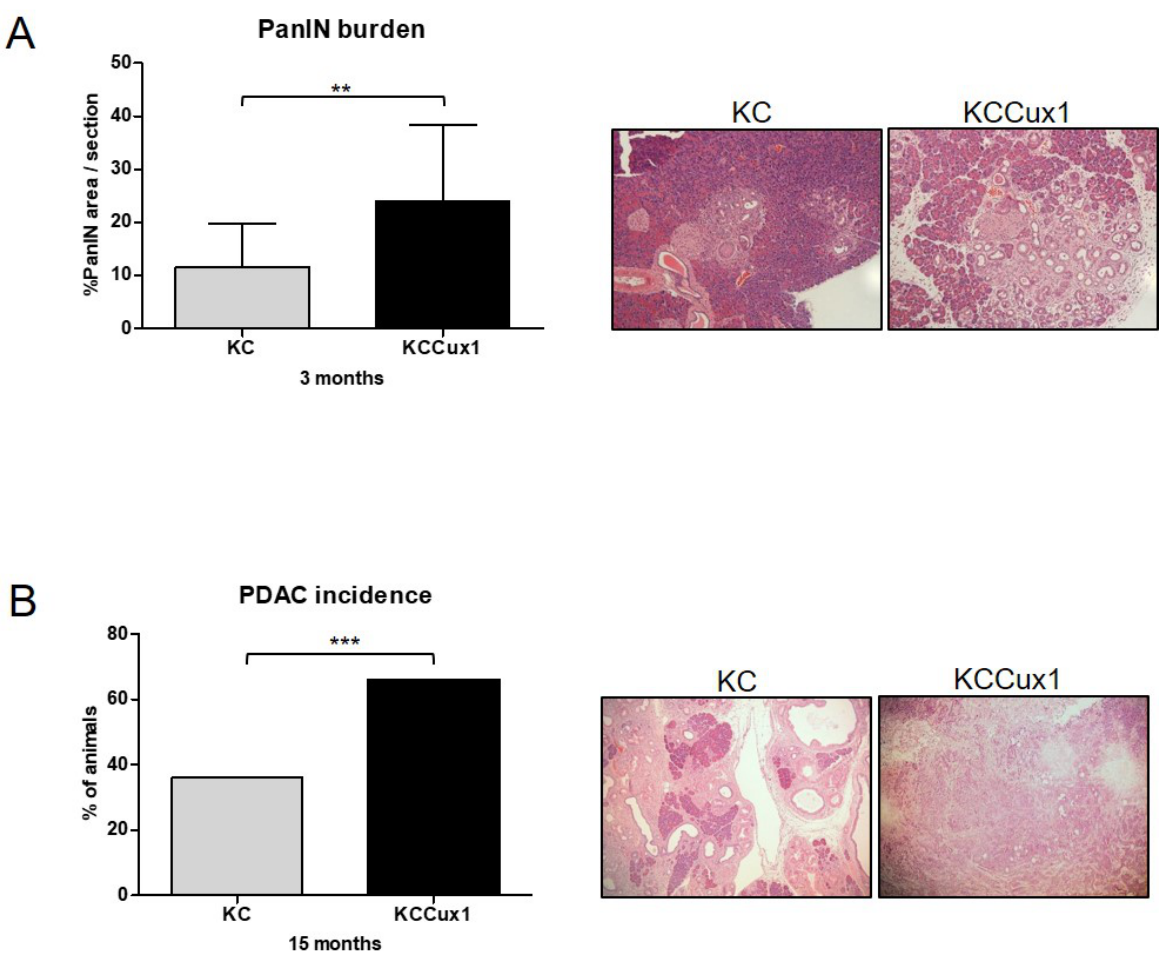
Figure 2. CUX1 accelerates KRAS-driven carcinogenesis and PDAC development. ( A ) Analysis of PanIN burden in 3-month-old KC (grey; n = 9) and KCCux1 (black; n = 9) mice, with representative H&E stainings (right). ** p ≤ 0.0025 by t -test. Data are shown as mean ± SD. ( B ) Percentage of 15-month-old tumor-bearing KC and KCCux1 mice, with representative H&E stainings (right). In the KC cohort (grey bar), 9 of 25 mice, and in the KCCux1 cohort (black bar), 20 of 29 mice showed an invasive PDAC. *** p ≤ 0.001 by Fisher’s exact test.